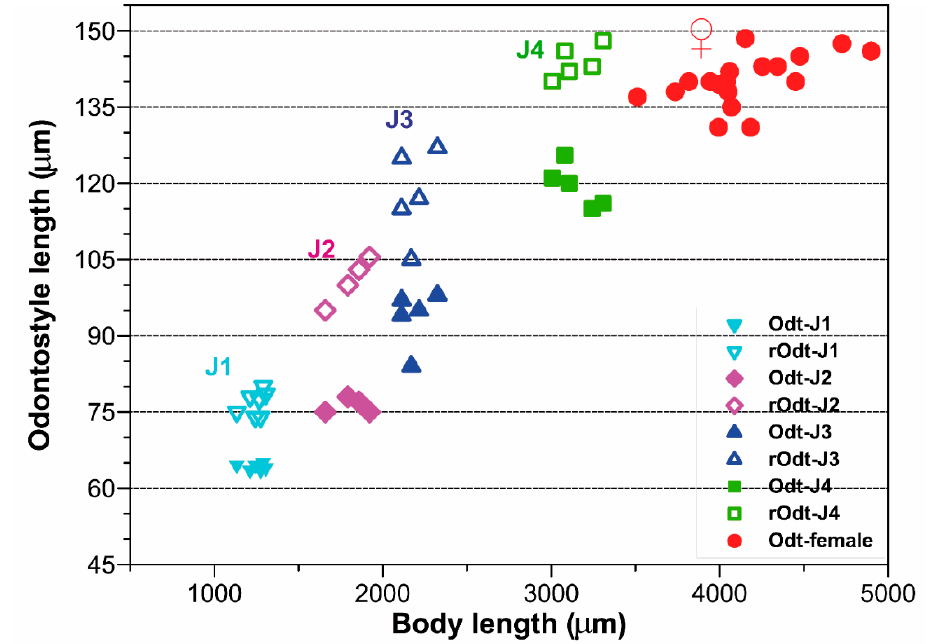
Figure 10. Relationship of body length to length of functional and replacement odontostyle (Ost and rOst, respectively) length in all developmental stages from first-stage juveniles (J1) to mature females of Xiphinema malaka sp. nov.